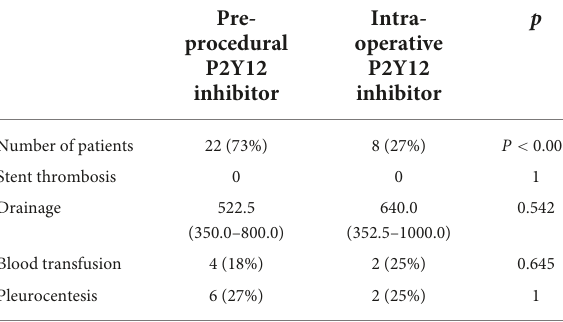
TABLE 7 Comparison of preprocedural and intra-operative P2Y12 inhibitor administration